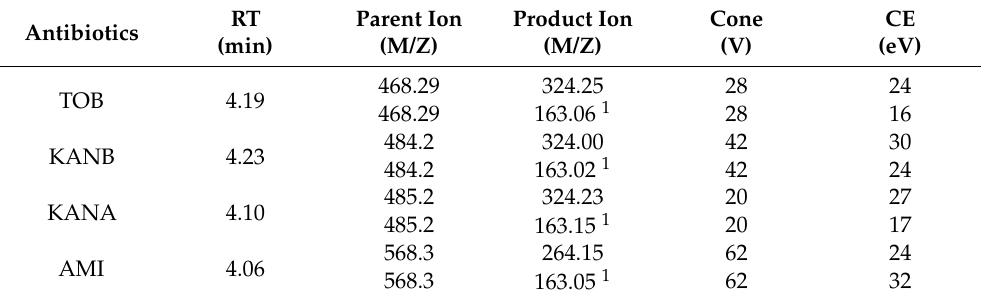
Table 3. MRM transitions and mass spectrometric condition parameters of four